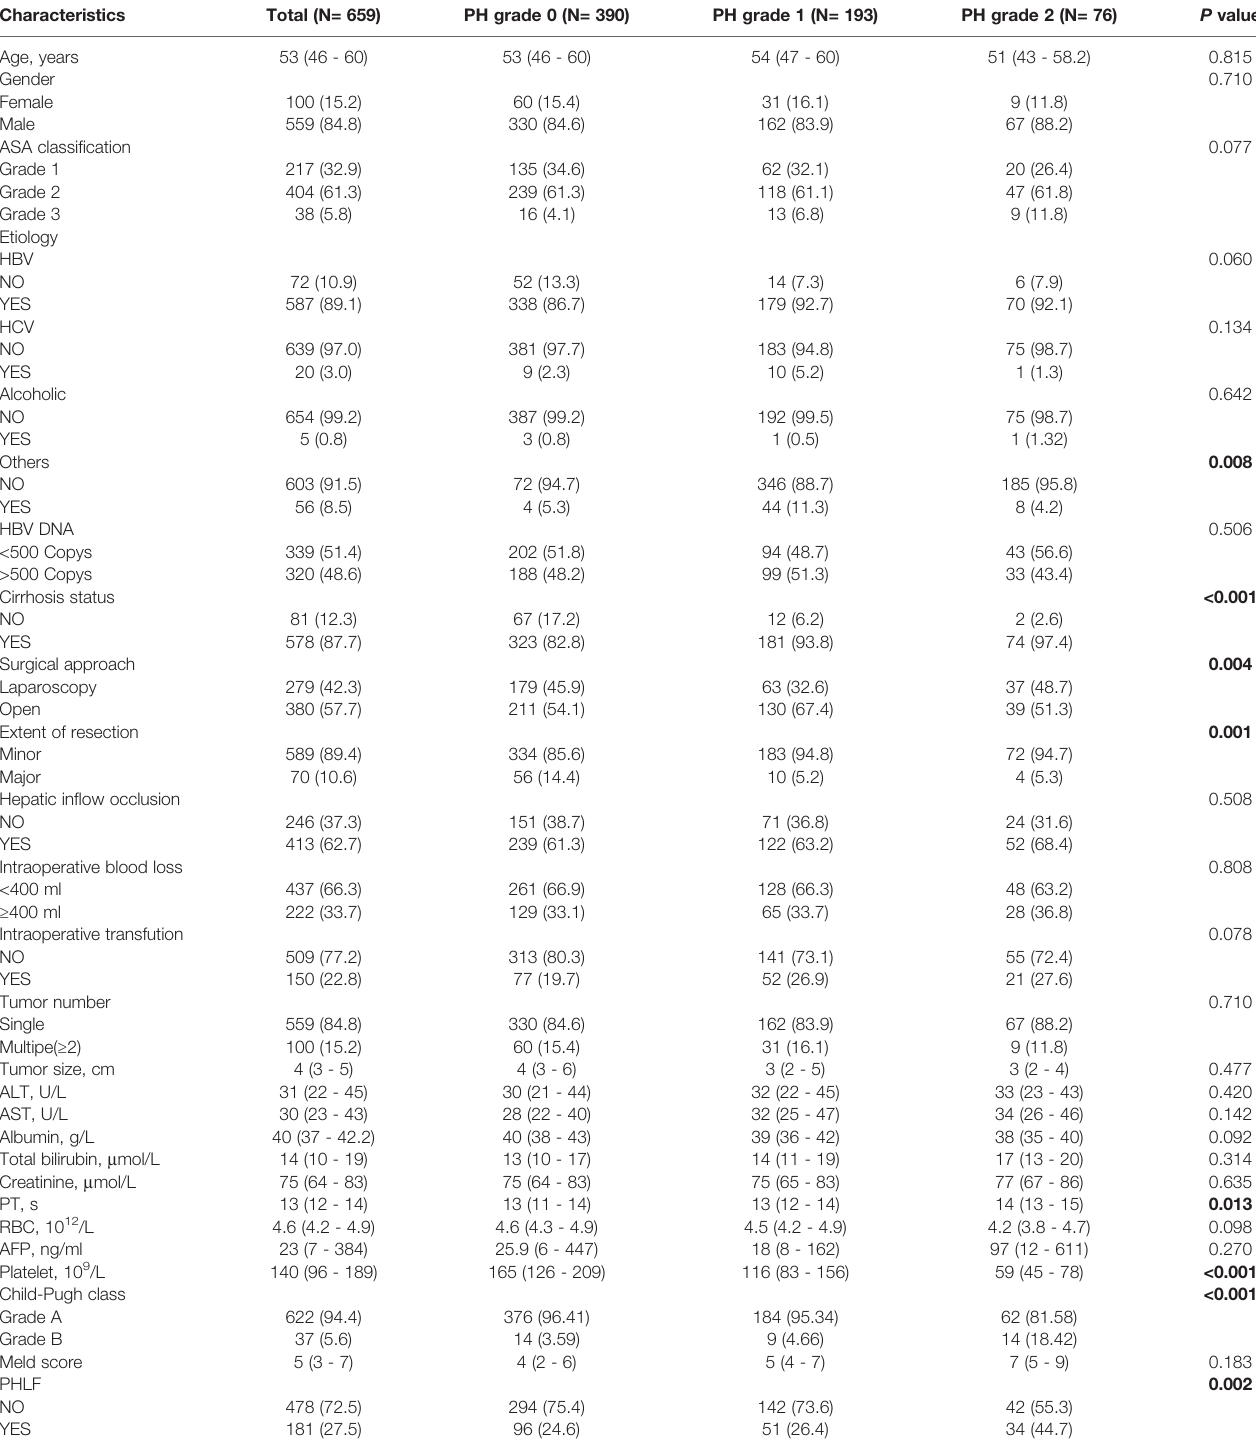
TABLE 1 | Comparisons of Characteristics between different portal hypertension grades.